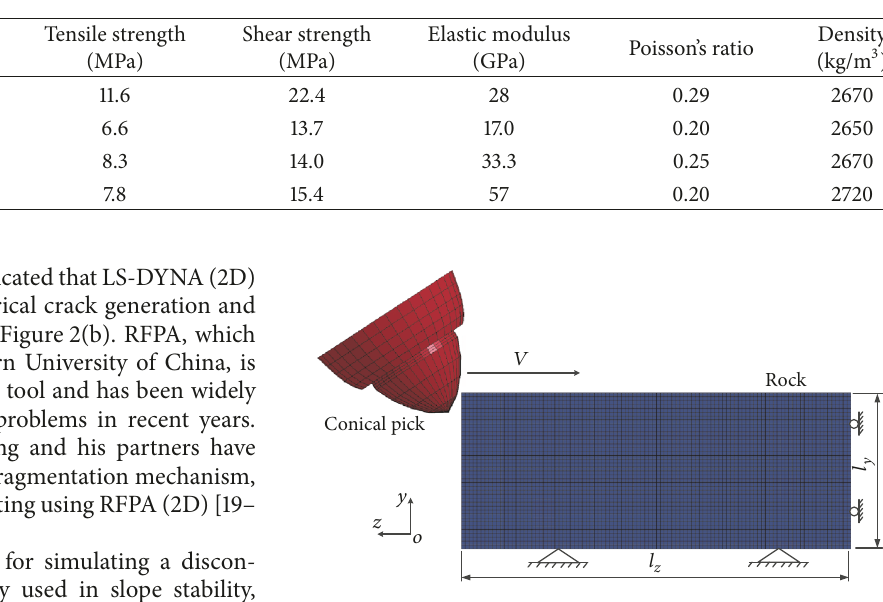
Table 2: Mechanical properties of the base rock [1].